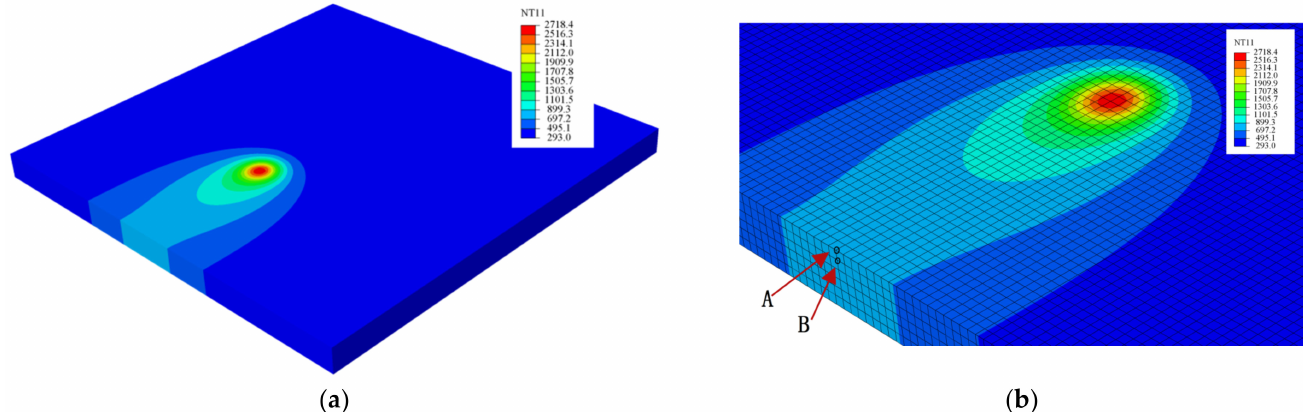
Figure 4. Simulation of the three-dimensional temperature field of Sic material based on Abaqus. ( a ) Three-dimensional temperature field, ( b ) a larger version of temperature